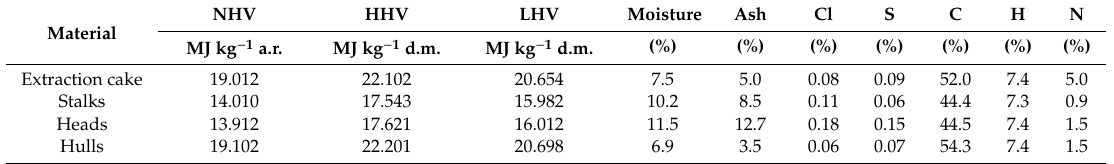
Table 7. Energy characterization of by-products and